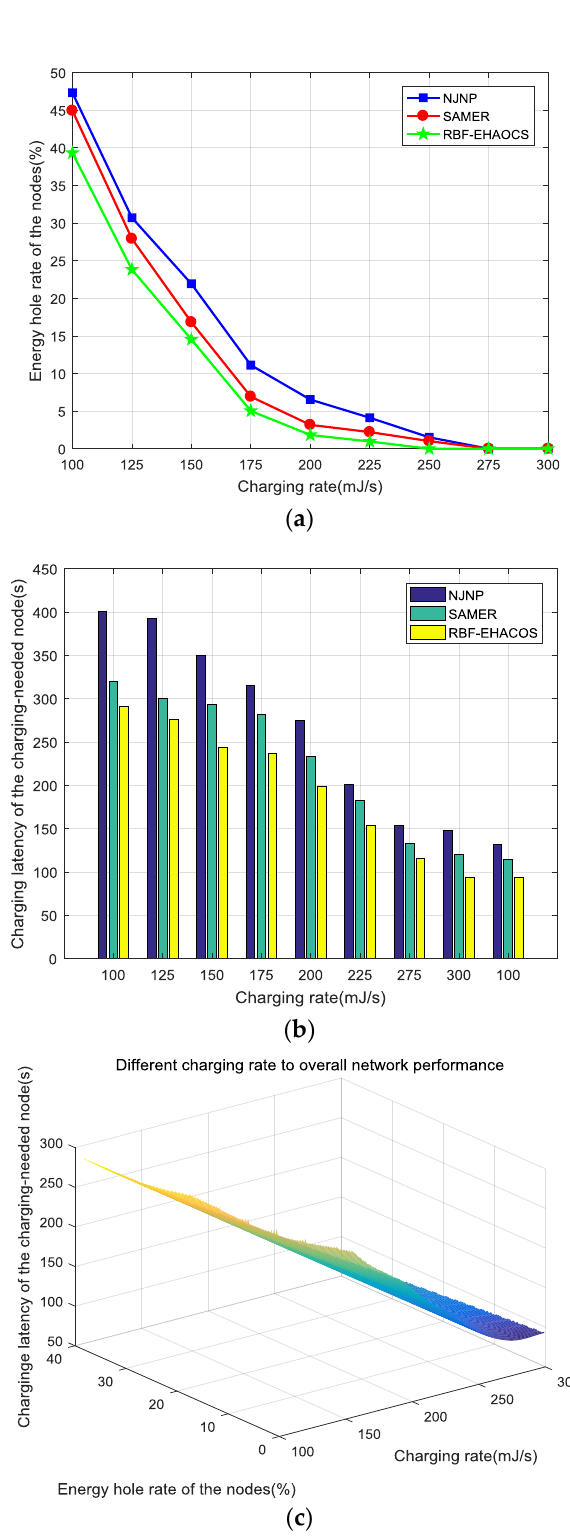
Figure 9. ( a ) Energy hole rate of the nodes, ( b ) charging latency of the charging-needed node, and ( c ) overall network performance.